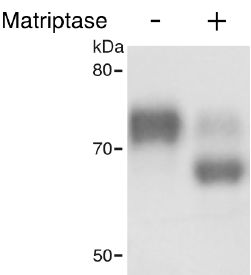
Figure 3. Matriptase cleaves TROP2 in vitro. 4 μ g of recombinant TROP2-Ig was incubated with or without 0.04 μ g of recombinant matriptase in 100 μ L of reaction buffer at 37 °C for 1 h. Reaction products were resolved via SDS-PAGE and stained with Coomassie blue. Representative data from 1 of 3 experiments is shown.